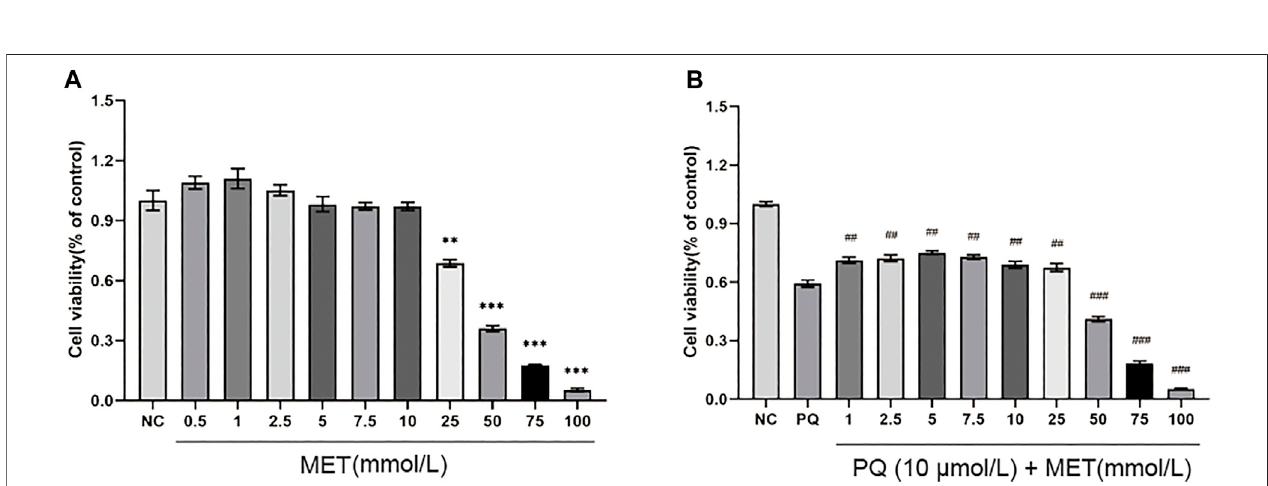
FIGURE4| TheeffectofMETontheviabilityofNR8383.DifferentconcentrationsofMET(0.5,1,2.5,5,7.5,10,25,50,75,and100 mmol/L)wereusedtointerfere with (A) NR8383 and (B) PQ-induced NR8383 for 48 h, and the cell viability of each group was calculated. Compared with the NC group, ** p < 0.01, *** p < 0.001, compared with the PQ group, ## p < 0.01, ### p < 0.001.